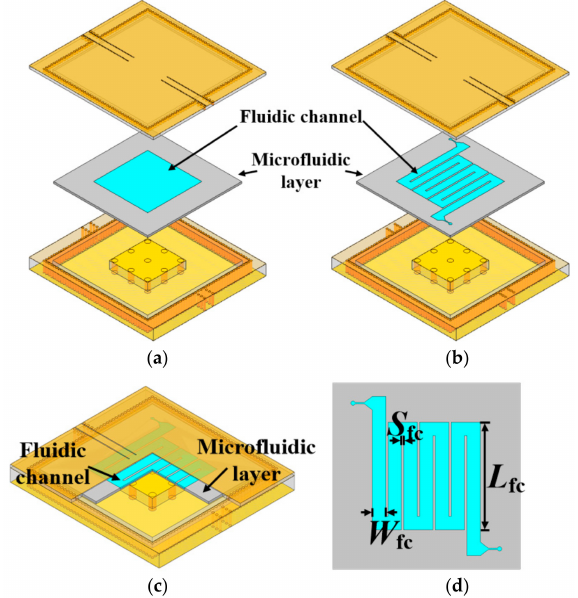
Figure 6. Diagram of the designed microfluidic subsystem: ( a ) 3-D view of the square plate channel design; ( b , c ) 3-D view of the winding channel design; ( d ) Front view of the winding channel